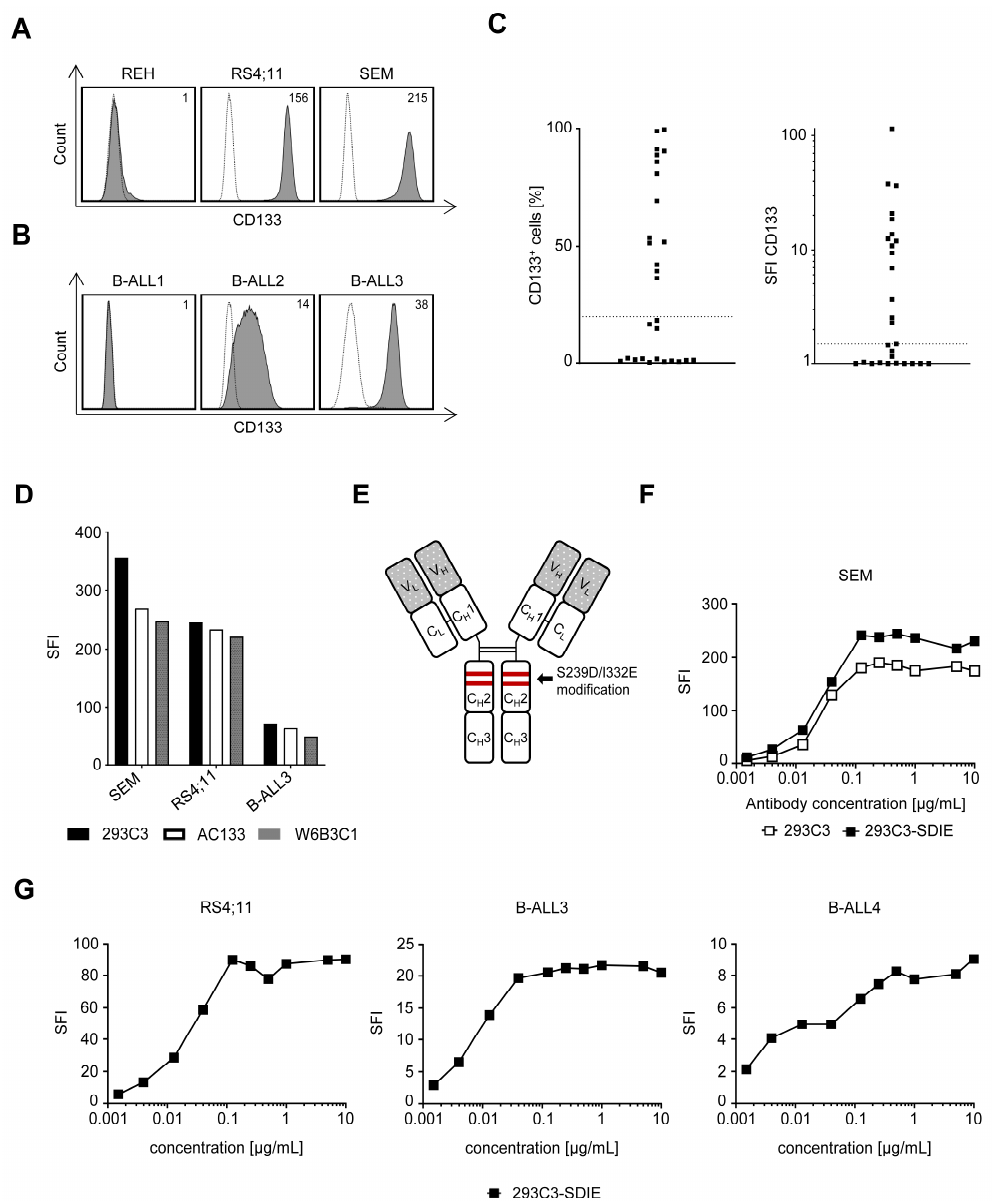
Figure 1. Characterization of 293C3-SDIE in B cell acute lymphoblastic leukemia (B-ALL). ( A – C ) B-ALL cell lines and primary leukemic cells of B-ALL patients were incubated with anti-human CD133 antibody clone 293C3 or mIgG2b as isotype control (both 10 µ g/mL) and analyzed by flow cytometry. ( A , B ) Exemplary data of CD133 expression on the B-ALL cell lines REH, SEM, and RS4;11 and three B-ALL patients (B-ALL1–3) (shaded peaks, anti-CD133; open peaks, control). Specific fluorescence intensity (SFIs) levels are depicted in the upper right corner. ( C ) Pooled data of CD133 expression on leukemic cells of primary B-ALL patients ( n = 28) depicted as % CD133 + B-ALL blasts (left, dotted line: 20% surface expression) and SFI levels (right, dotted line: SFI = 1.5). ( D ) The B-ALL cell lines SEM and RS4;11, as well as the leukemic cells of an exemplary B-ALL patient (B-ALL3), were incubated with mouse anti-human CD133 antibody clones 293C3, AC133, W6B3C1, or mIgG1 and mIgG2b as isotype controls (all 1 µ g/mL) and analyzed by flow cytometry. ( E ) Schematic illustration of 293C3-SDIE. ( F ) The B-ALL cell line SEM was incubated with increasing concentrations of the mouse anti-human CD133 antibody 293C3 or 293C3-SDIE and mIgG2b or iso-SDIE as isotype controls (10 µ g/mL) and analyzed by flow cytometry. ( G ) The B-ALL cell line RS4;11 and the leukemic cells of two exemplary B-ALL patients (B-ALL3 and B-ALL4) were incubated with increasing concentrations of 293C3-SDIE or iso-SDIE (10 µ g/mL) and analyzed by flow